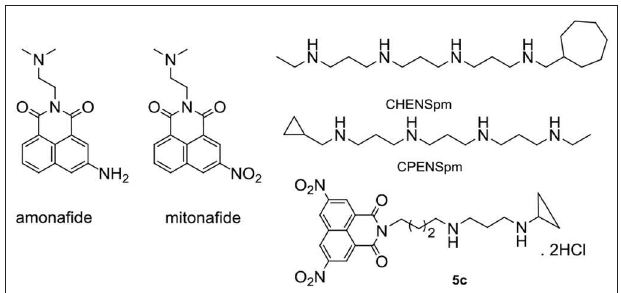
FIGURE 1 | Chemical structures of amonafide, mitoafide, polyamine analogs CHENSpm, and CPENSpm, and target compound 5c .